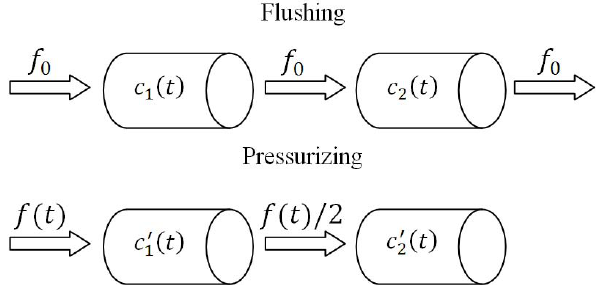
Fig. 6. The schematic of the flask sampling process for the case of pair flasks, which consists of two steps: flushing and pressurizing. During the flushing, air flows into and out of the first flask at a flow rate f 0 (the air is fully mixed inside the first flask) and then flows into and out of the second flask at the same flow rate, f 0 . During the pressurizing process, air flows into the first flask at a varying flow rate f (t) , but out of the first flask at the flow rate f (t) /2; air at the flow rate f (t) /2 pressurizes the second flask.